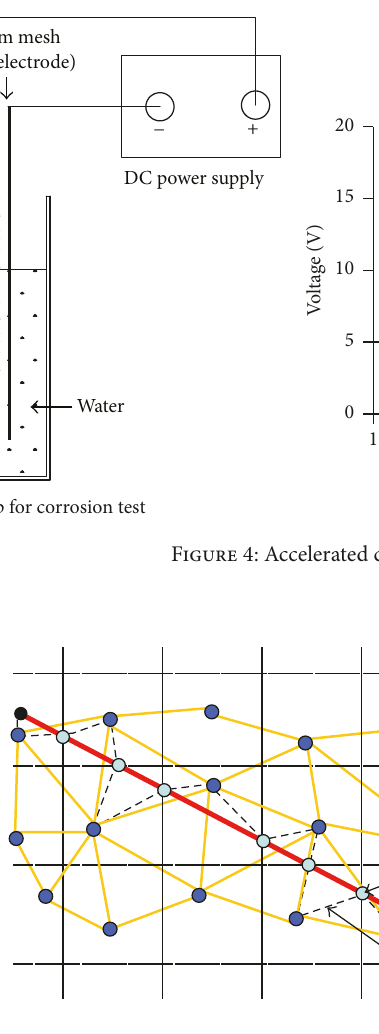
Figure 5: Schematic 2D representation of generation of fibre-lattice